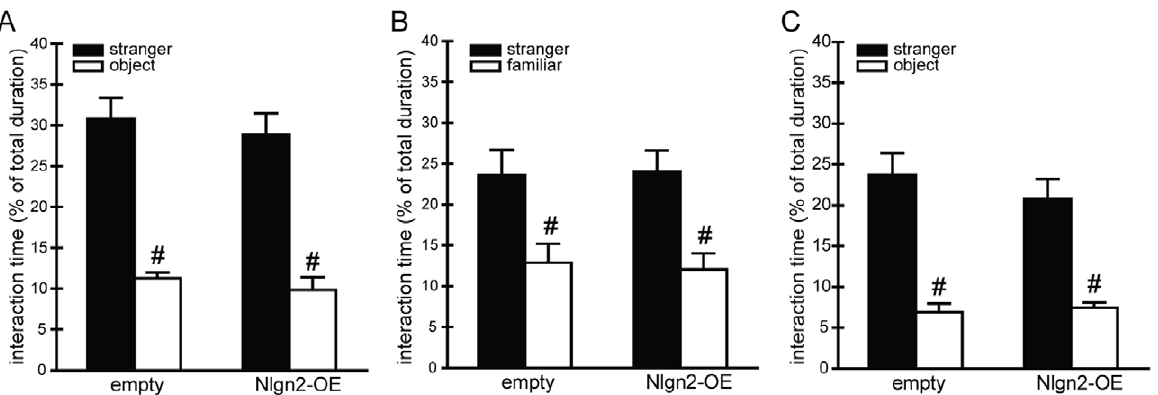
Figure 3. Social behavior. A–B Sociability-social memory. A, Sociability. Interaction times with stranger juvenile and object. All animals spent more time investigating the juvenile compared to the object (F (1,18) =65.40, p , 0.001), but there was no difference between the groups. B, Social memory. Interaction times with stranger and familiar juveniles in the social memory trial. Both groups significantly explored more the stranger juvenile compared to the familiar juvenile (F (1,18) =19.614, p , 0.001), which they already encountered in the first trial for the sociability test. No differences concerning the interaction times between the groups could be detected. C, Sociability after RI test. The animals of both groups spent significantly more time with the juvenile compared to the object (F (1,18) =58.023, p , 0.001), but between the groups we did not observe any